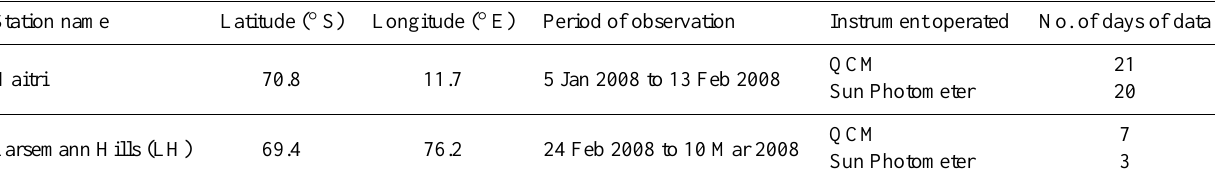
Table 1. Period, number of days of observation and name of the instruments operated at Maitri and Larsemann Hills, in Antarctica during 27th ISEA.